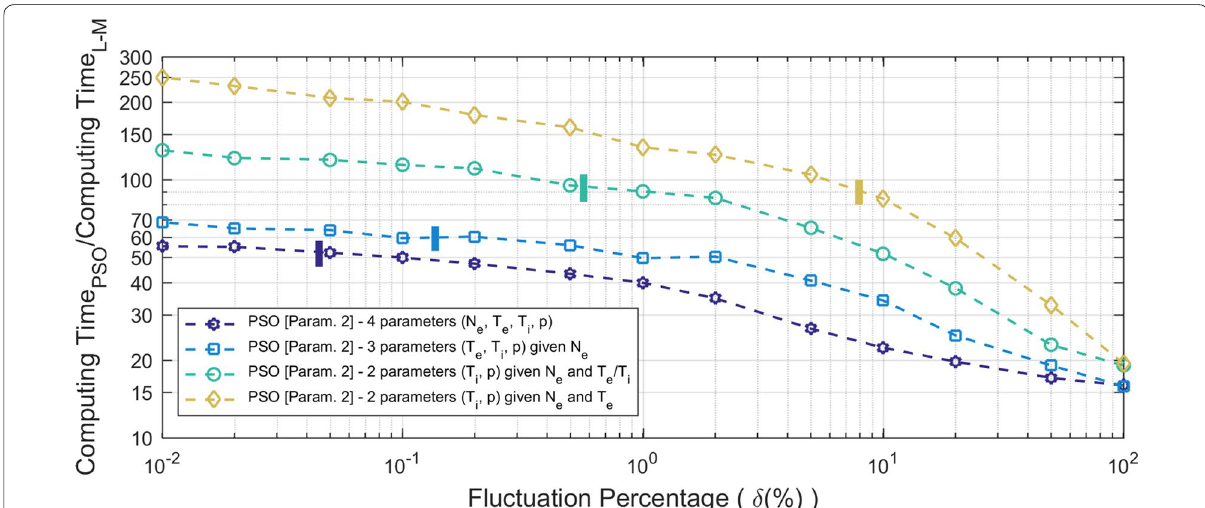
Fig. 11 Ratio between computing times of fittings using the PSO algorithm relative to fittings of the L–M algorithm at different signal fluctuation percentages ( δ( % ) ). Vertical bars indicate the signal fluctuation thresholds of the MCLM method, for which the MCLM method should require only one L–M fit with random initial